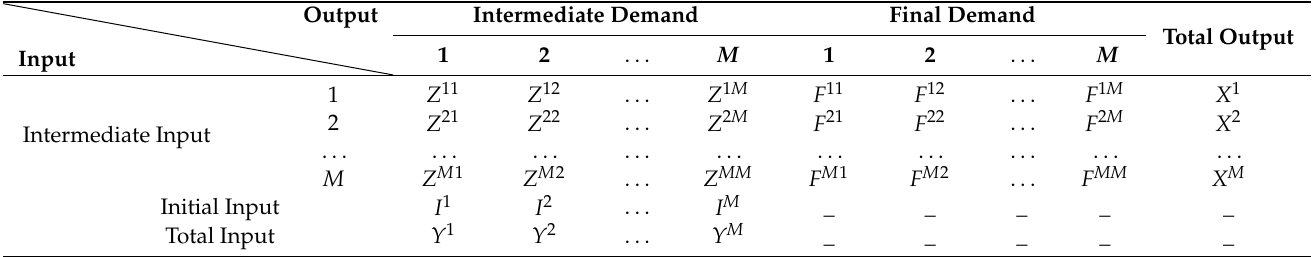
Table 1. International Multi-Region Input-Output